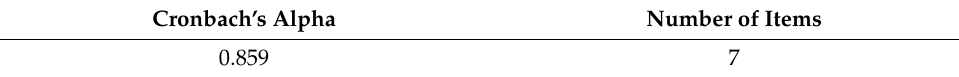
Table 3. Reliability statistics of